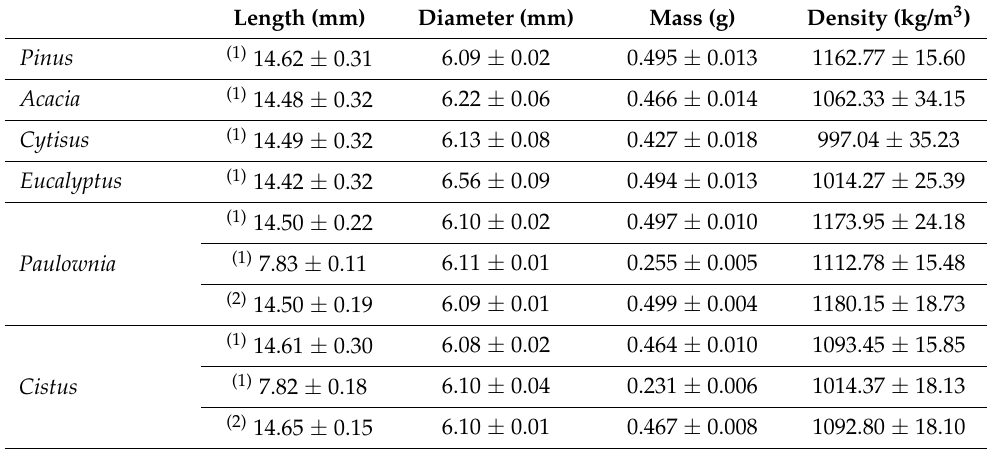
The results show minor differences between the experimental pellets’ dimensions, mass and